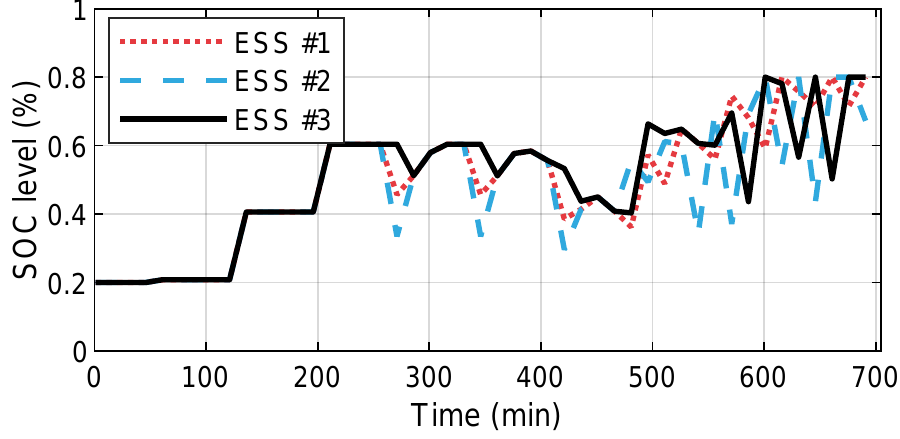
Figure 9. The change of each ESS’s SOC using proposed rolling horizon